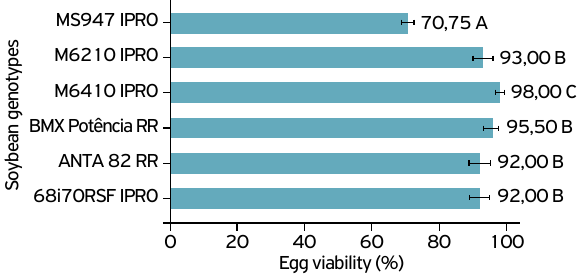
Figure 1. Egg viability (%) of Bemisia tabaci B biotype on soybean genotypes, Dourados (MS), Brazil,